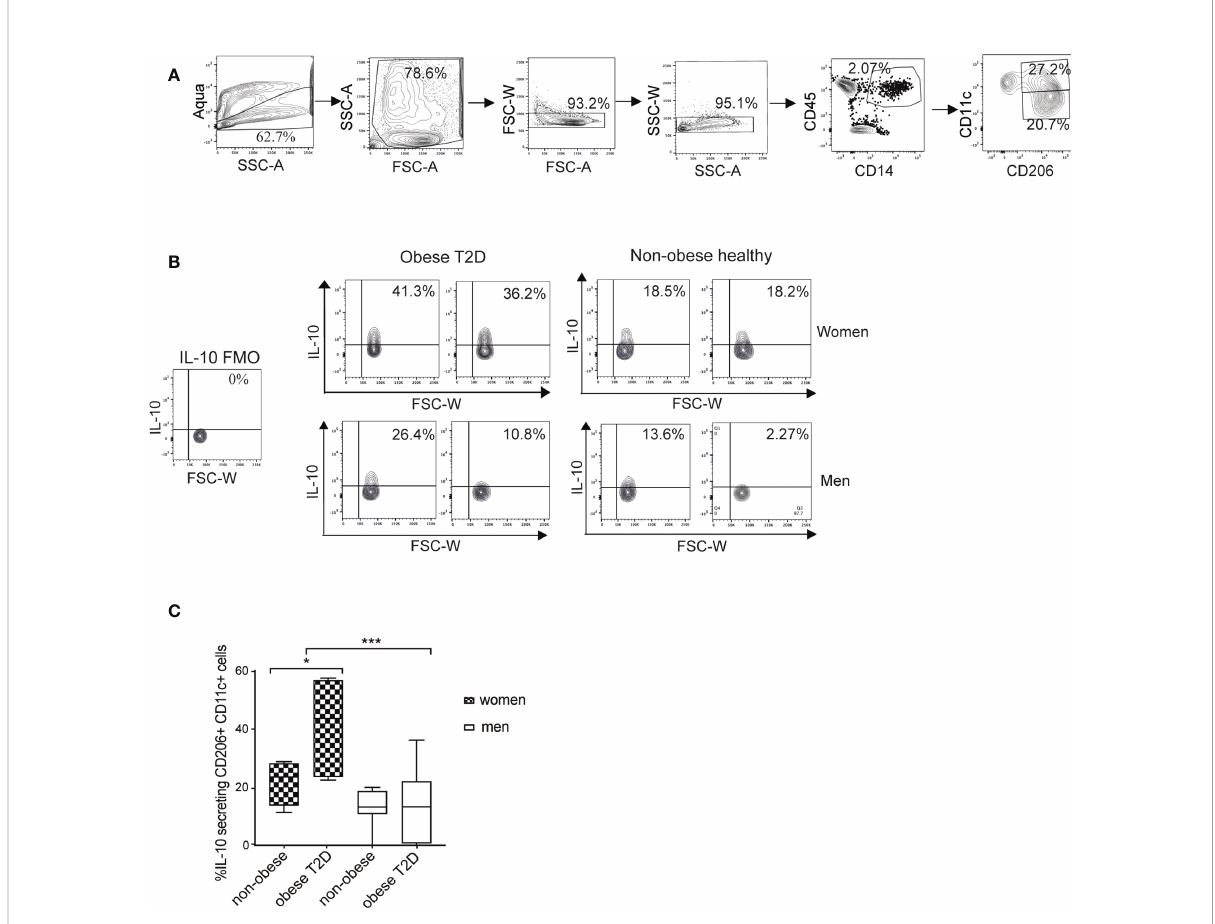
FIGURE 2 Amount of IL-10 secreting macrophages is increased in scWAT of women with obesity and T2D but not in men. (A) A fl ow cytometry gating strategy. Selection of alive single cells (four panels on the left), macrophage/monocyte (CD45 + /CD14 + ) and M1 macrophage (CD45 + /CD14 + / CD206 + /CD11c + ) selection (two right-side panels). (B) The M1 macrophage population was then analyzed for IL-10 secretion. Representative contour plots from two individuals/group are shown for obese T2D and non-obese healthy women and men. FMO control samples are shown on the left side. (C) Compiled results of IL-10-secreting macrophage populations for non-obese healthy (n=8 for both men and women) and obese T2D (n=7 for women, n=8 for men) men and women from cohort 1 . Two-way ANOVA with Tukey ’ s and Sidak ’ s multiple comparisons were used in (C) to compare between the groups in men and women and to compare the groups between men and women respectively. *** <0.001, * <0.05.